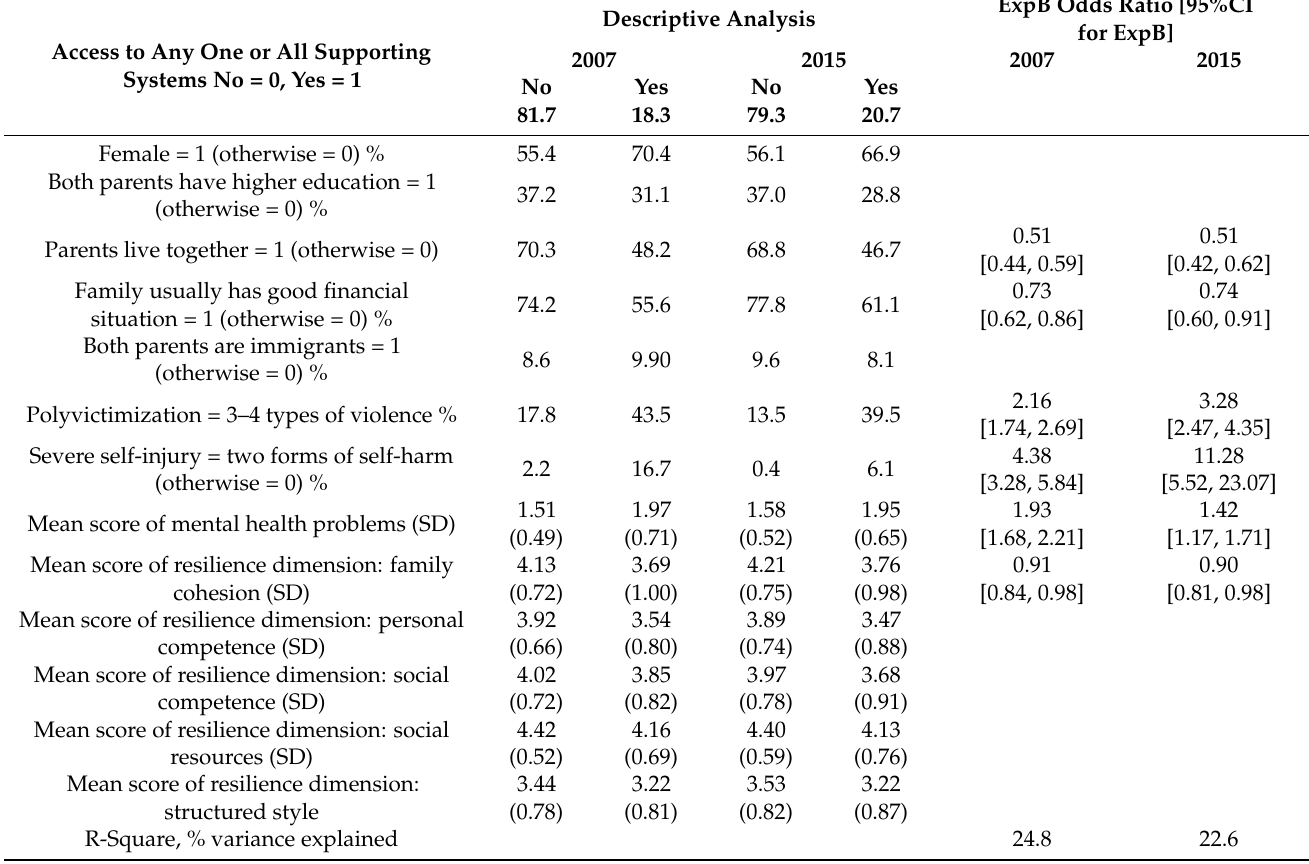
Table 4. Variables of background, severity of adversities, resilience and their relationship to young people’s access to all support systems: descriptive and logistic regression